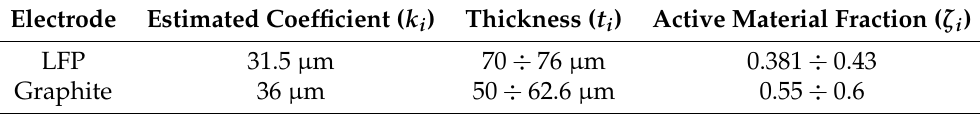
Table 3. Results of least mean square estimation and electrode properties from in situ measure- ments [30,44–47].